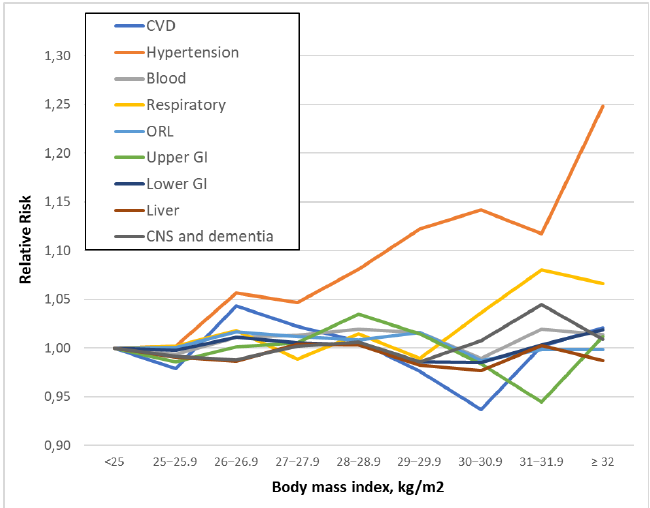
Figure 2. Association of BMI with specific disorder category